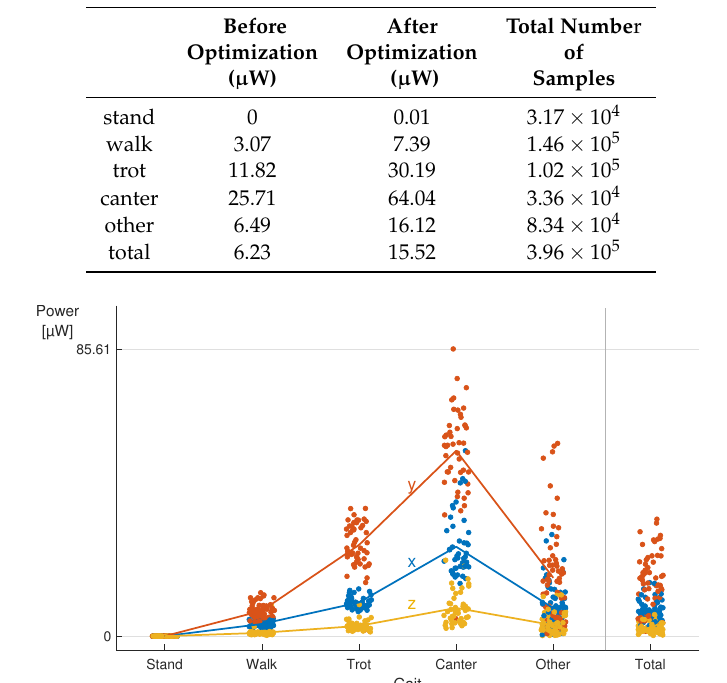
Table 3. Energy available in the sensor node when the horse is in different gaits. Canter has the highest average power, during stand almost no power is generated. Optimization of the resonance frequency can give high improvements, in particular for the higher energetic gaits.